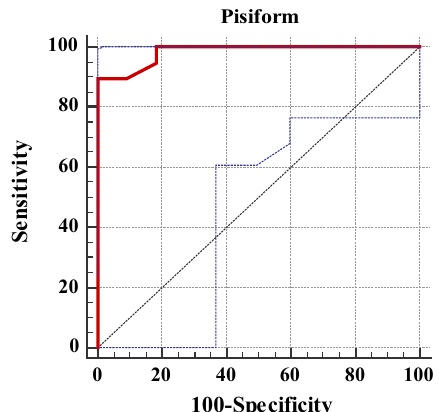
Fig. 6 ROC curve for the diagnostic performance of ADC value at pisiform level